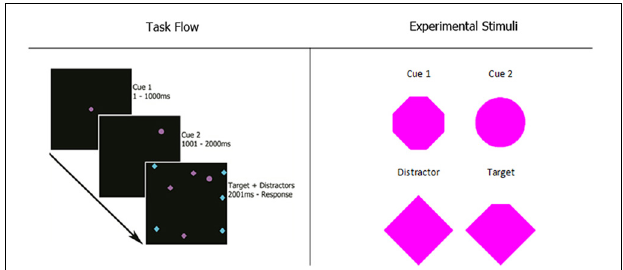
FIGURE 1 | Experiment 1 task flow and magnified stimuli. Cue 1 appeared in the center of the screen for 1s. After it disappeared, cue 2 appeared in a random location. After another 1-s interval, the search array appeared with the target and all distractors in random, non-overlapping locations. Possible stimuli colors were magenta and cyan. The size of every stimulus was 0.8 degrees of visual angle. Participants reported which of the four corners of the target was missing with the corresponding arrow key on the computer